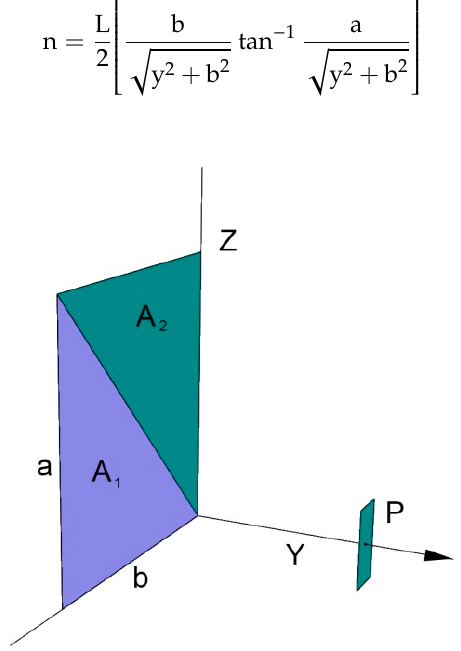
Figure 2. Configuration factor between a rectangle consisting of two united triangles (A 1 and A 2 ) and a point belonging to a parallel